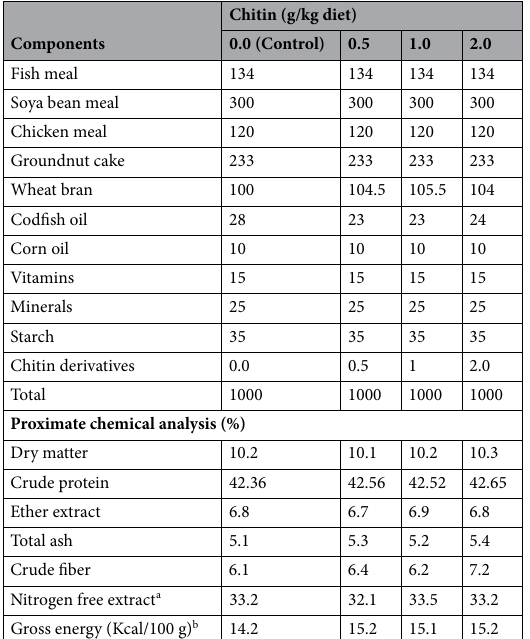
Table 1. Chemical composition of feed supplements (% dry weight) containing various levels of chitin derivatives. a Nitrogen free extract (NFE) = 100 – (protein % + lipid % + total ash % + crude fiber %). b Gross energy was calculated according to NRC (1993) as 5.65, 9.45, and 4.11 kcal/g for protein, lipid, and carbohydrates,